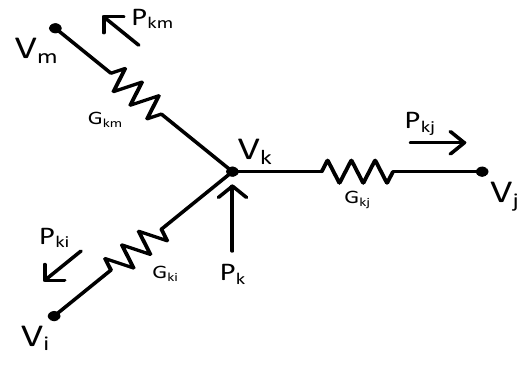
Figure 5. Power flow in a multi-bus system (based on Kirchhoff’s